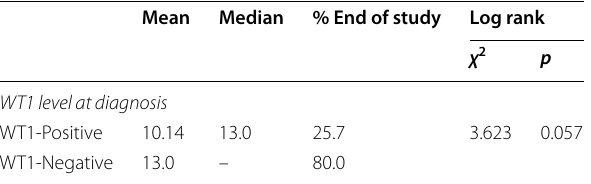
χ 2 : Chi square test, FE: Fisher Exact p : p value for association between different categories * Statistically significant at p 0.05 ≤ Table 7 Kaplan–Meier survival curve for overall survival with WT1 expression ( n 40) =